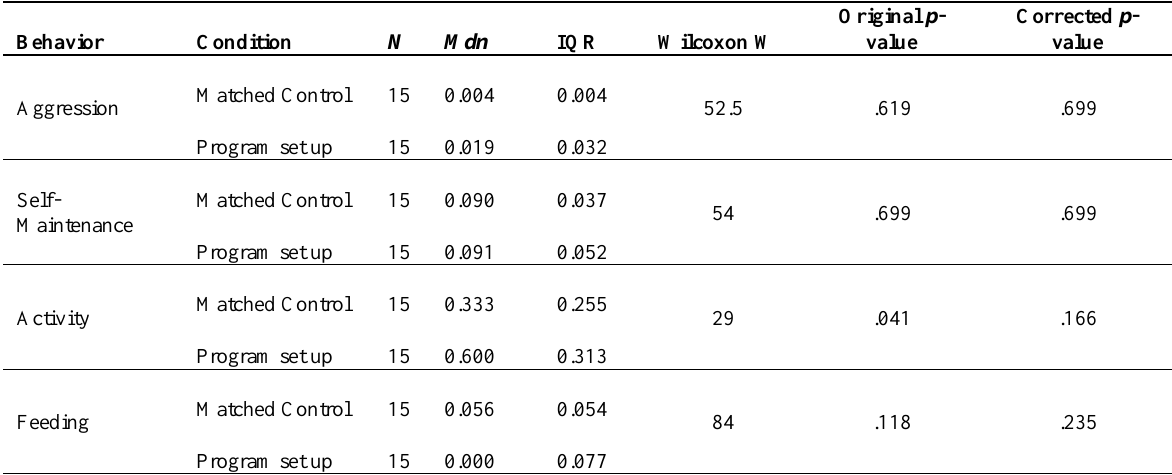
Results of Comparisons of Behavior During Program Setup and Matched Control Periods